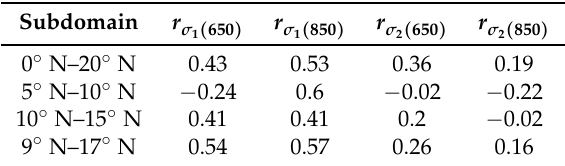
Table 1. Linear correlation coefficients r between σ 1 and σ 2 for winds at the 850- and 650-hPa levels and the difference in the number of identified precipitation features with γ p ,2 D = 70 mm day − 1 (Figure 6c) per subdomain as shown in Figure